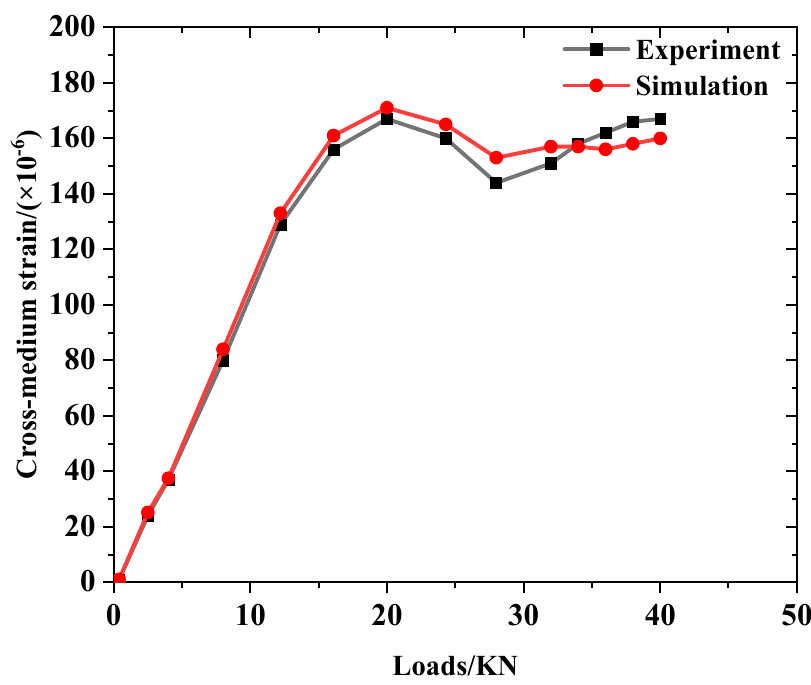
Figure 11. Numerical simulation of plain concrete frame and comparison of strain in the frame structure test.